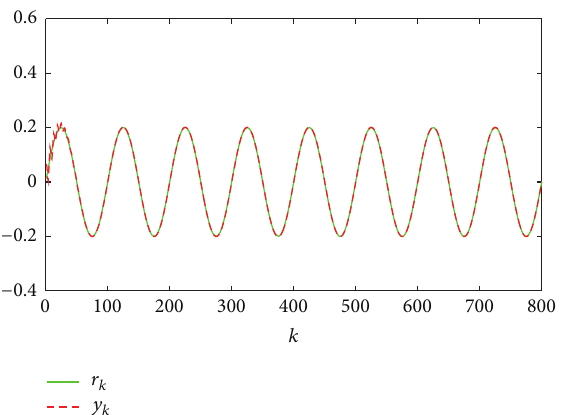
Figure 3: Nonlinear systems adaptive control by using OS-ELM.